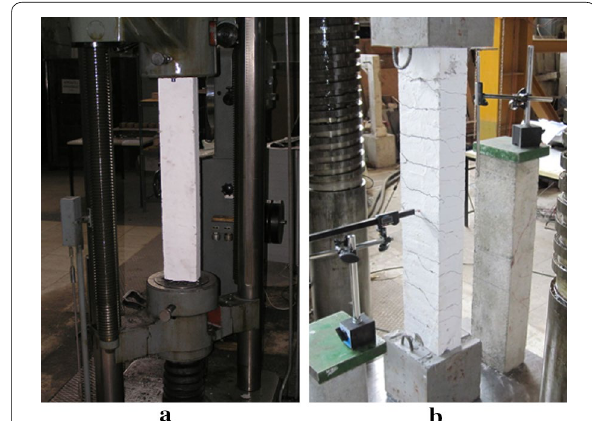
Fig. 2 Loading test configuration for: a tensile loading, b compressive